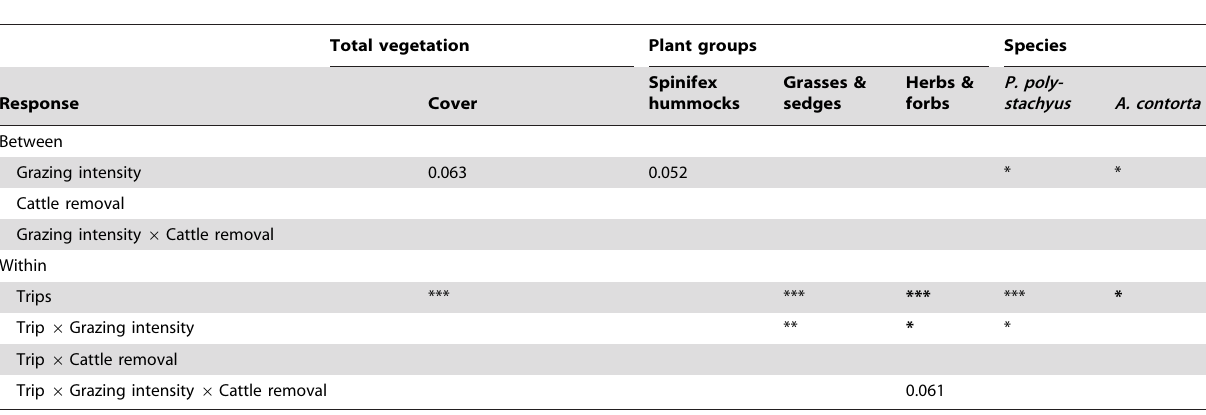
Table 1. Summary of repeated measures ANOVA results on the effects of grazing history and cattle removal on the abundance of vegetation.